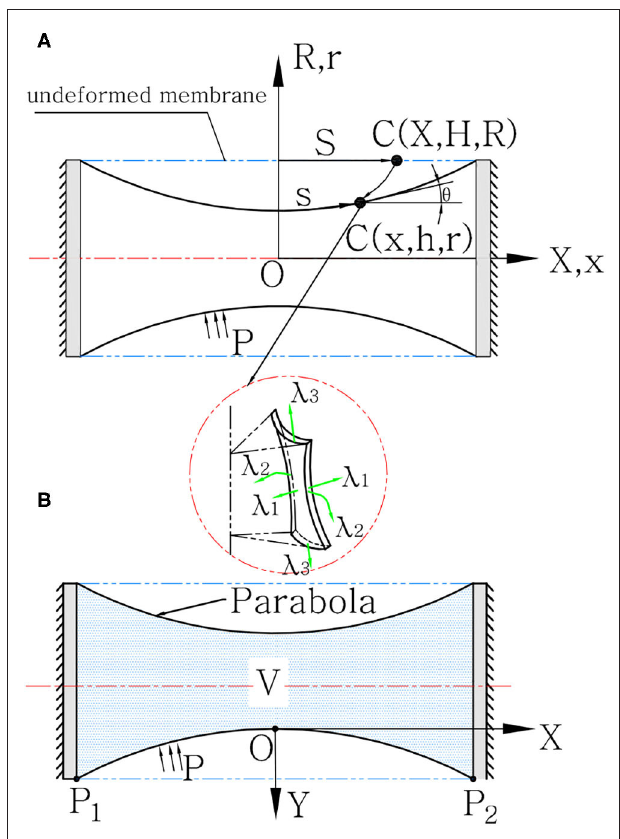
FIGURE 3 | SPCAM’s quasi-static model. (A) The profiles of undeformed and deformed hyperelastic latex membrane under coordinate systems (X, H, R) and (x, h, r), respectively. The detail view illustrates the principle stretches λ 1 , λ 2 , and λ 3 of a material particle. (B) The profile of deformed polyethylene membrane under the coordinate system (x, y).